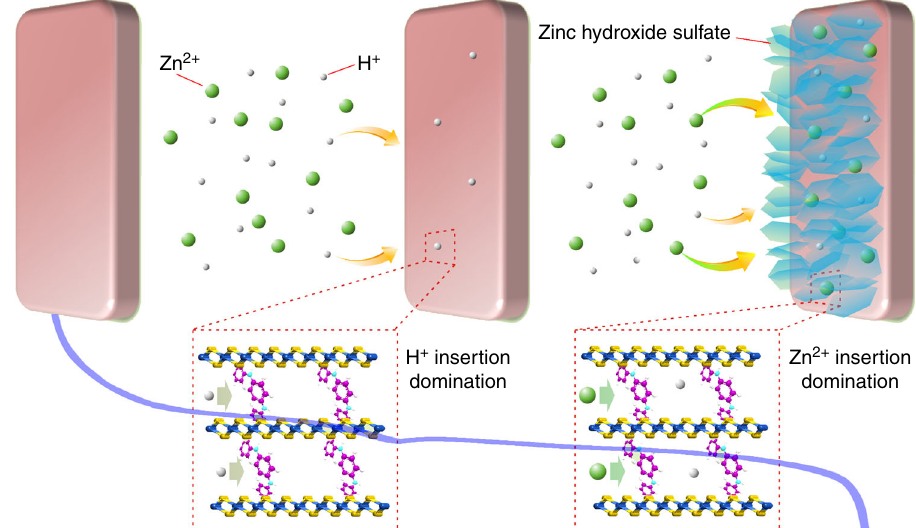
Fig. 5 Diagram showing the sequential insertion of H + and Zn 2 + . During the fi rst discharge platform, H + insertion into polyaniline (PANI)-intercalated MnO 2 nanolayers dominates the electrode reaction, which gradually decreases H + concentration around the electrode. With a sustained decrease of H + , Zn 2 + insertion dominates the electrochemical reaction, raising the second discharge platform; meanwhile, the sustained decrease of H + concentration leads to the formation of zinc hydroxide sulfate on the electrode